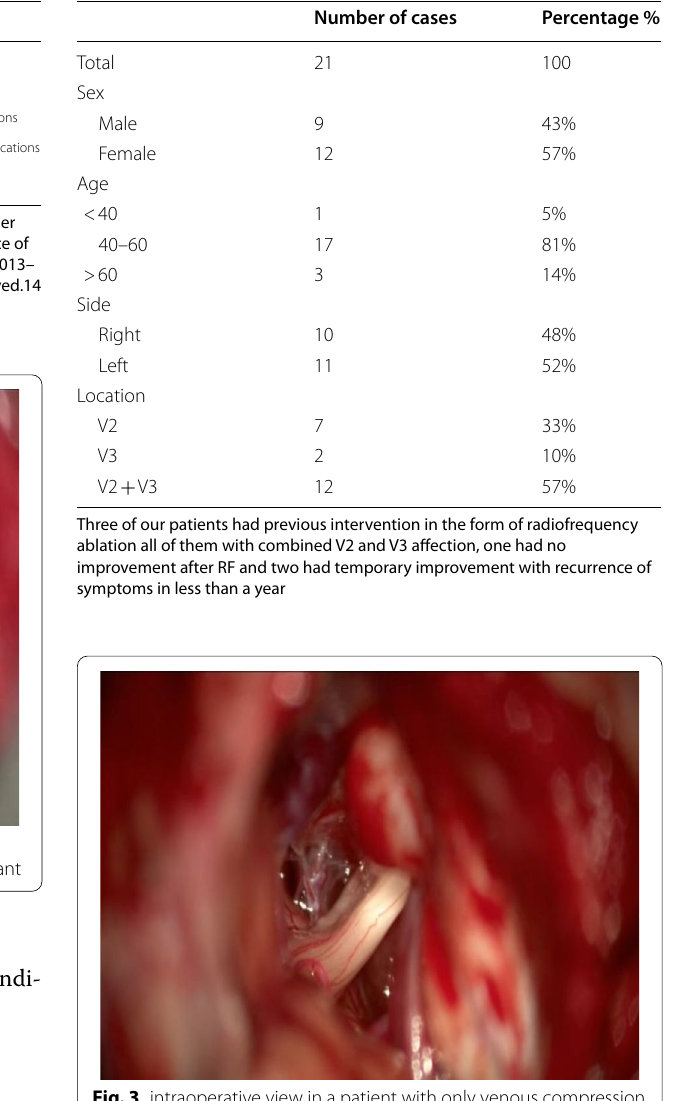
Table 2 Summary of the patients’ characteristics